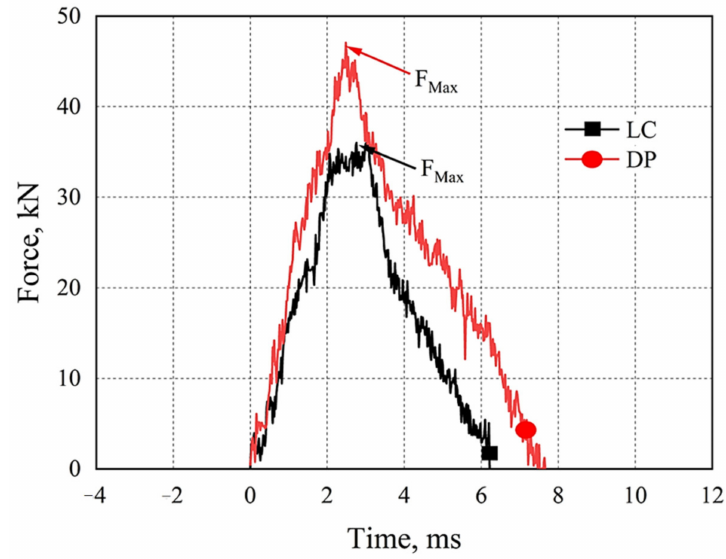
Figure 9. Force–time behavior of LC and DP steel.